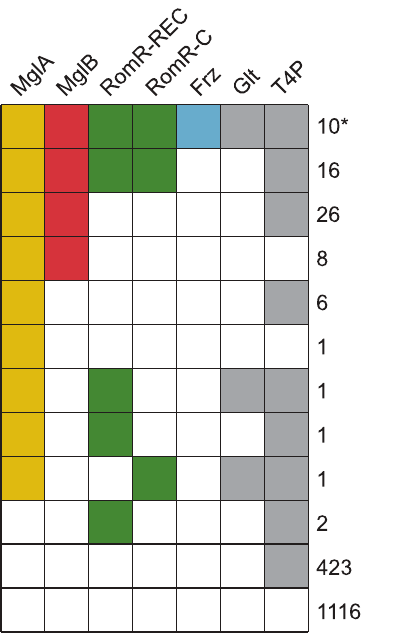
Figure 2. The genomic distributions of RomR and Frz overlap with those of MglA and MglB. Each column represents the presence of absence of MglA, MglB, RomR-REC, RomR-C, Frz, the gliding motility machinery (Glt), or T4P as a colored or white box, respectively. Numbers on the right indicate the number of genomes with a given pattern of co-occurrence. The * indicates the M. fulvus genome that contains an incomplete RomR, a complete MglA/MglB system, and Frz system. Analysis of the DNA sequence neighboring its romR suggests that the truncation of romR is a recent occurrence or the result of a sequencing error because we were able to find neighboring DNA that is nearly identical to the RomR-C encoding portion of romR in M. xanthus .